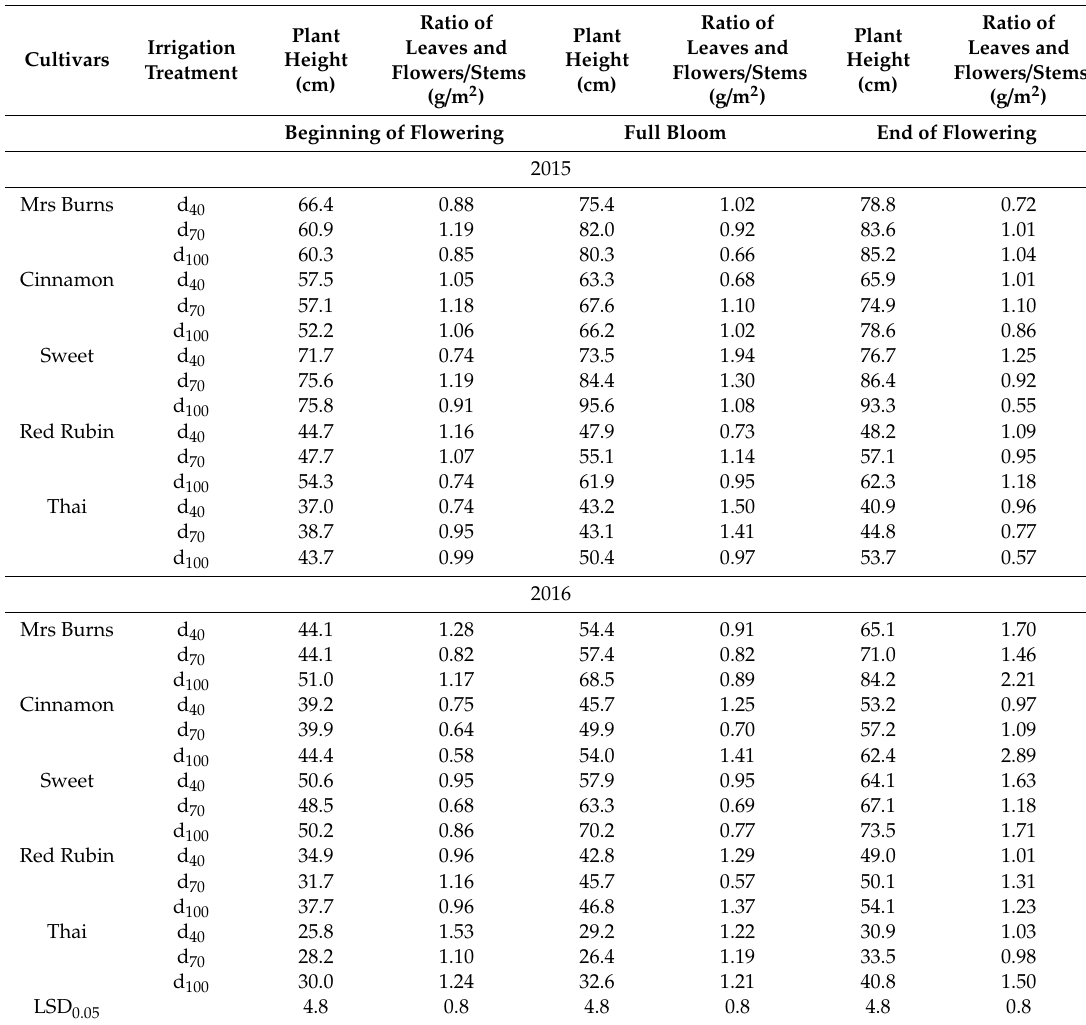
Table 5. Combined e ff ect of Cultivar, Irrigation, Year (2015, 2016), and Growth Stages on plant height and ratio of leaves and flowers / stems. Data presented are mean values, where LSD is the least significant di ff erence at the 0.05 significance